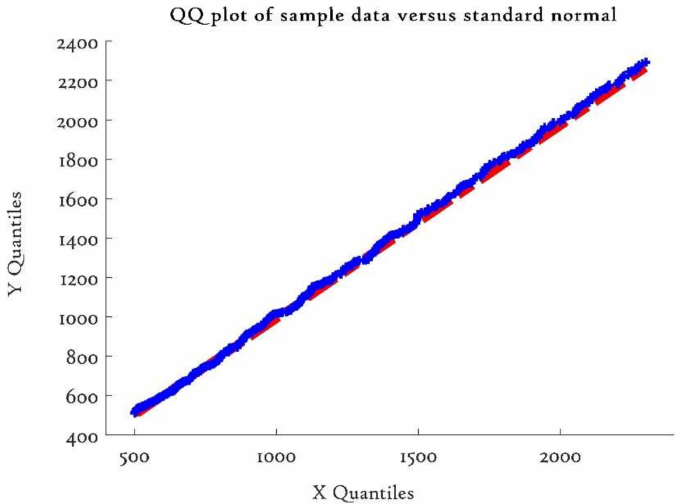
Figure 20. QQ plot for GP rotor power